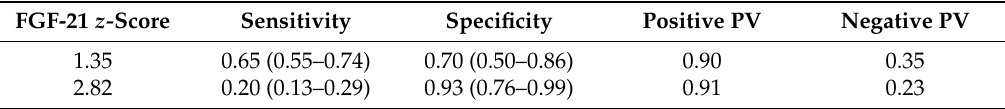
Figure 3. Receiver operating characteristic curves comparing FGF-21 z -scores, lactate concentration, and the product of FGF-21 and lactate concentrations for the diagnosis of mitochondrial disease. The curves were established using data from 104 MD and 27 non-MD patients. See Table 2 for further details on the diagnostic performance of FGF-21 z -scores. Table 2. Performance of log-transformed FGF-21 z -scores for diagnosing mitochondrial disease. FGF-21 z -scores refer to thresholds. Figures in brackets are 95% confidence intervals. PV is predictive value.